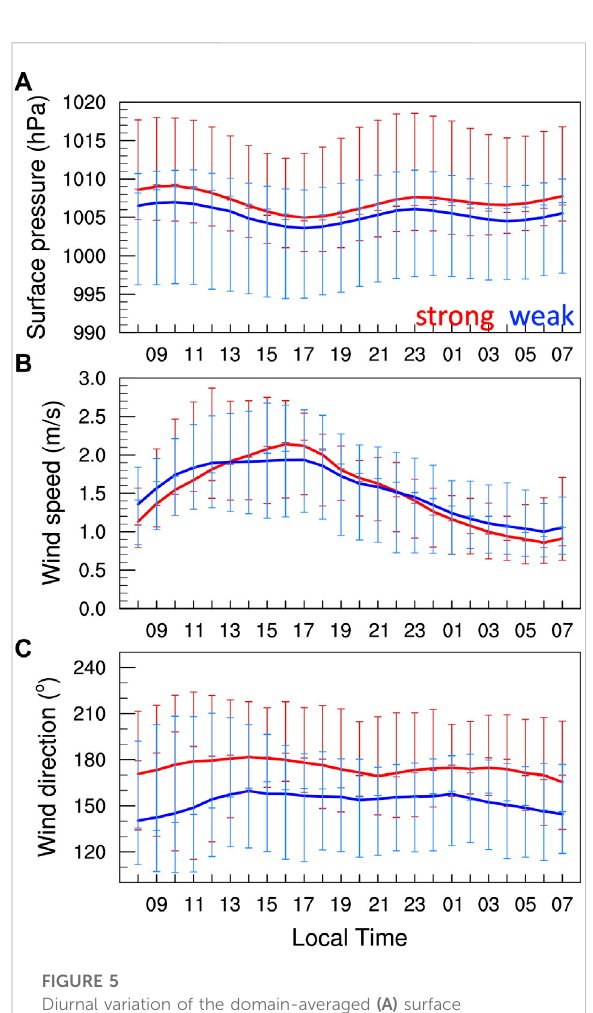
FIGURE 5 Diurnal variation of the domain-averaged (A) surface pressure (units: hPa), (B) wind speed (units: m/s), and (C) wind direction (units: degree) for strong-UHI days (red) and weak-UHI days (blue). The error bars denote the 25th, 50th and 75th percentile of the data at each local